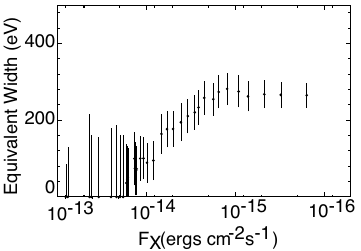
Figure 2: X-ray color-color diagram of all detected X- ray sources. The converted median energy is shown in the upper x -axis. Color difference shows groups defined in § 2.1.3.